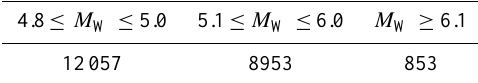
Table 1. Earthquakes considered in the present